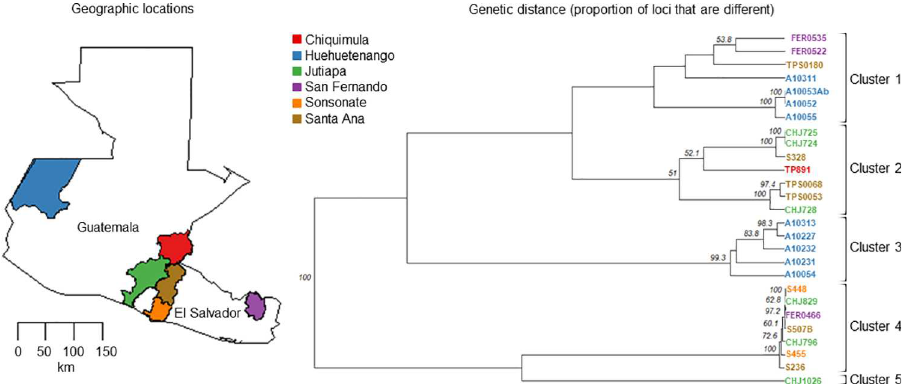
Fig 5. UPGMA Dendrogram based on Nei’s genetic distances among TcI samples across locations from Guatemala and El Salvador. Node support was assessed by bootstrap. Nei’s genetic distances matrix involved 57 SNPs from 27 samples. Colors represent each of the geographic locations evaluated. Base layer for each country and state/ department were downloaded from the GADM database of Global Administrative Areas, version 3.6 (https://gadm. org/download_country.html) and maps were plotted using the R package mapdata [28].